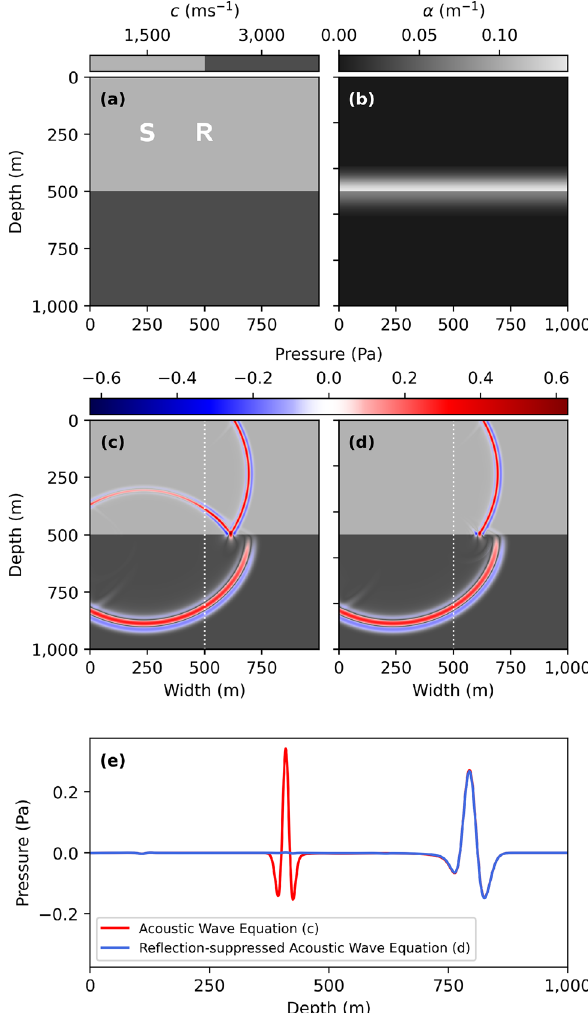
Figure 1. ( a ) The wave-speed of a 2 layer velocity-profile with point source location S and ( b ) local suppression constant α( (cid:31) r ) . ( c ) shows a snapshot of the wave-field at t = 0.35 s for the acoustic wave Eqs. (1, 2) and ( d ) the reflection-suppressed wave Eqs. (3, 4), using a peak frequency of 50 Hz, 10 grid-points per smallest wavelength, and a CFL 20 number of 0.5. The resulting space interval and step-size become (cid:31) x = 1.0 m and (cid:31) t = 1.6 · 10 − 4 s, respectively. ( e ) shows a cross-section through snapshots ( c ) and ( d ) along the white dotted-line. A video of all snapshots is available as supplementary